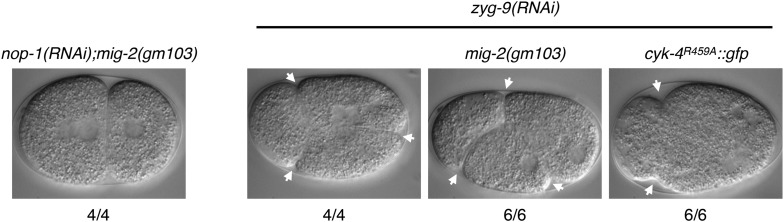
A gain of function mutation, mig-2(gm103), does not affect cytokinesis in sensitized backgrounds.NOP-1 or ZYG-9 was depleted from mig-2(gm103) embryos and the progression of cytokinesis was followed by nomarski imaging. Cytokinesis proceeds to completion in the former case, and both anterior (left) and posterior (right) furrows are formed in the latter case. ZYG-9 was depleted from cyk-4R459A::gfp embryos for comparison demonstrating loss of the posterior furrow.